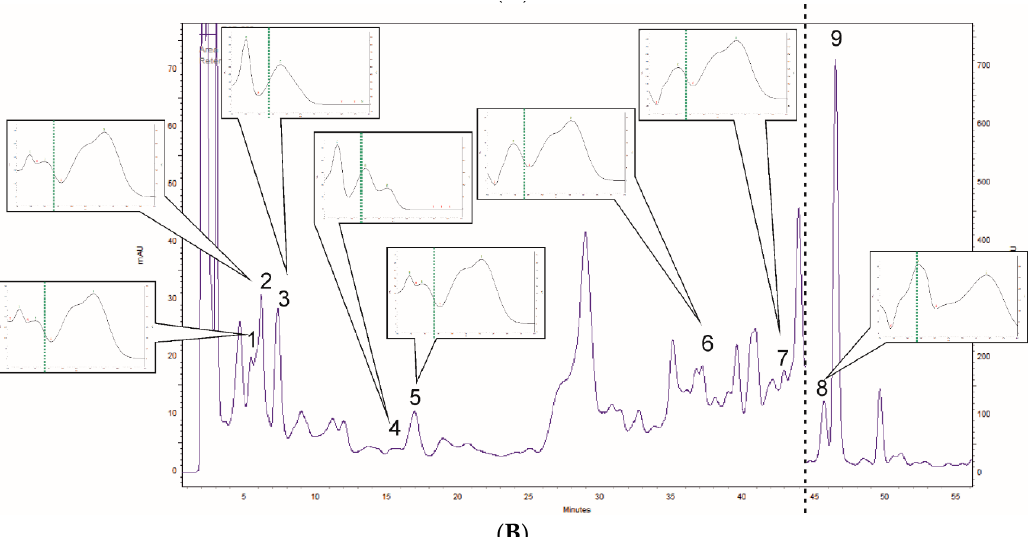
Figure 1. The examples of HPLC-DAD chromatographic separation ( λ = 254 nm) of leaf extracts of: ( A ) R. o ffi cinalis (1—gentisic acid, 2—vanillic acid, 3—ca ff eic acid, 4—rosmarinic acid); and ( B )